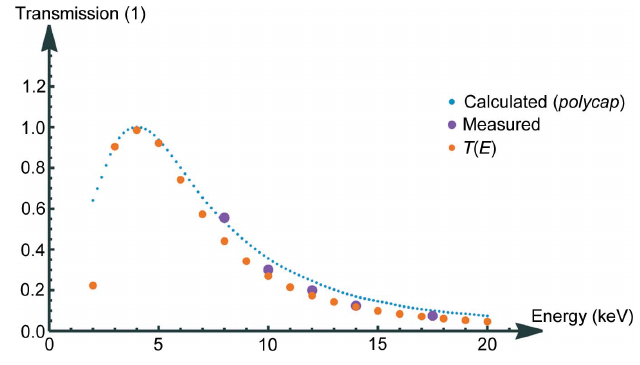
Figure 17 Model for the transmission function compared with single energy measurements made at the synchrotron and Monte Carlo simulations performed with polycap . The calculated and simulated values of the various energies are normalized to the maximum transmission at approximately 4 keV. The measured values are scaled accordingly to illustrate the trend of energy